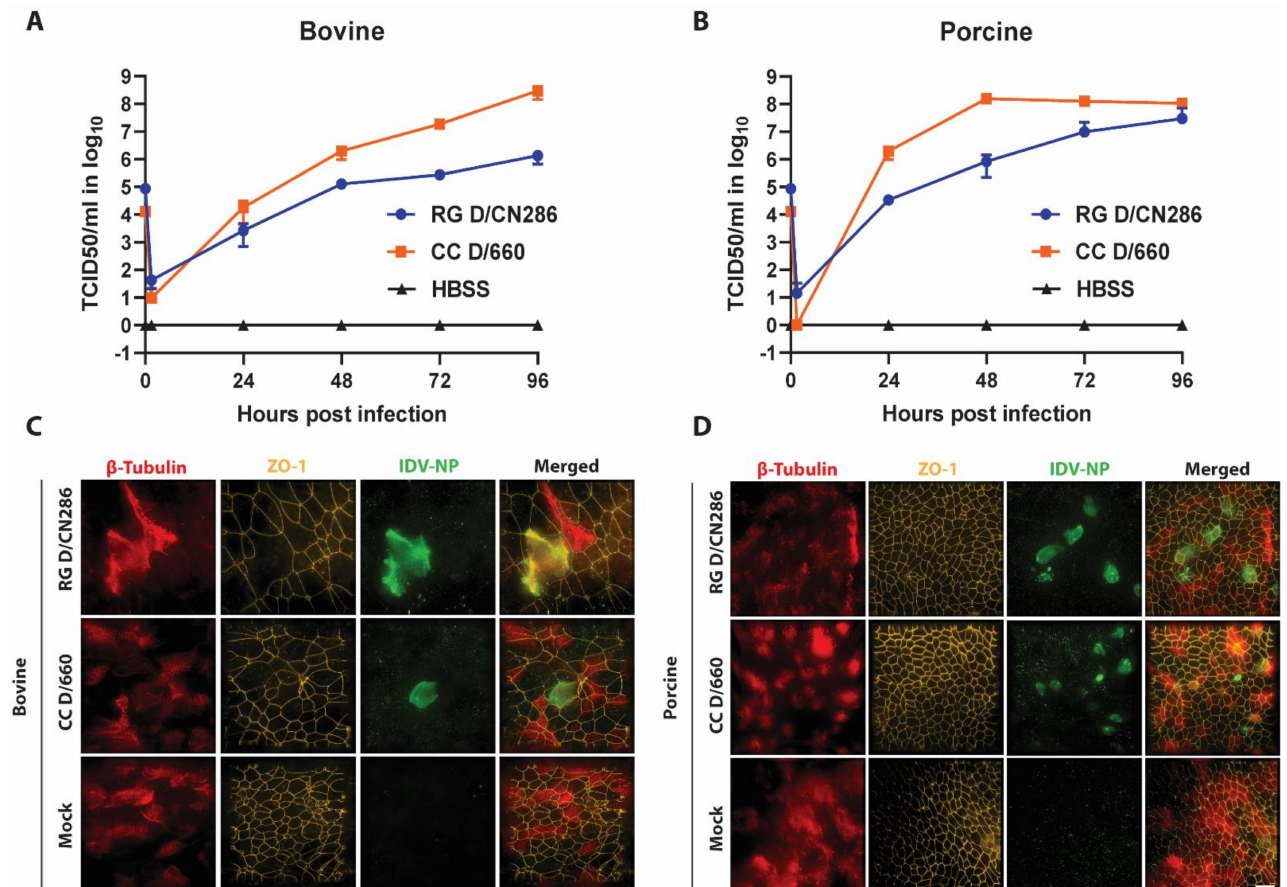
Figure 5. Replication kinetics and determination of the cellular tropism of the rescued Influenza D virus (IDV) clone on well-differentiated airway epithelial cell (AEC) from bovine and porcine origin. The AEC cultures were infected with 10.000 Tissue culture infectious dose 50 (TCID 50 ). of the rescued IDV clone (RG D/CN286) or cell culture grown IDV (CC D/660). The replication kinetics were monitored for 96 h of incubation at 37 ◦ C and 5% CO 2 , whereby apical washes were collected every 24 h and analysed by viral titration followed by formalin-fixation and preparation for immunostaining. Viral infectious titres ( Y -axis) of the corresponding apical washes are shown as TCID 50 /mL as indicated hours post infection ( X -axis), of the infected bovine ( A ) or porcine derived AEC cultures ( B ). Results are shown as means and SD of two technical replicates of one biological donor. Formalin-fixed AEC cultures were immunostained with antibodies visualizing cilia ( β -tubulin, red), tight junction borders (ZO-1, orange) and virus antigen (IDV-NP, green) of bovine ( C ) and porcine ( D ) derived AEC cultures. Magnification is 60 × , scale bar represents 20 µ